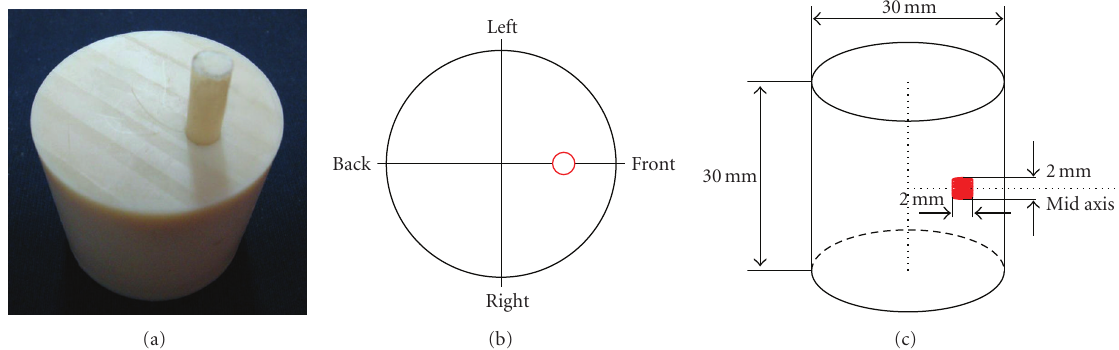
Figure 4: Experimental setup. (a) Physical phantom, (b) Four perspectives for CCD camera to register outgoing photons, (c) Numerical